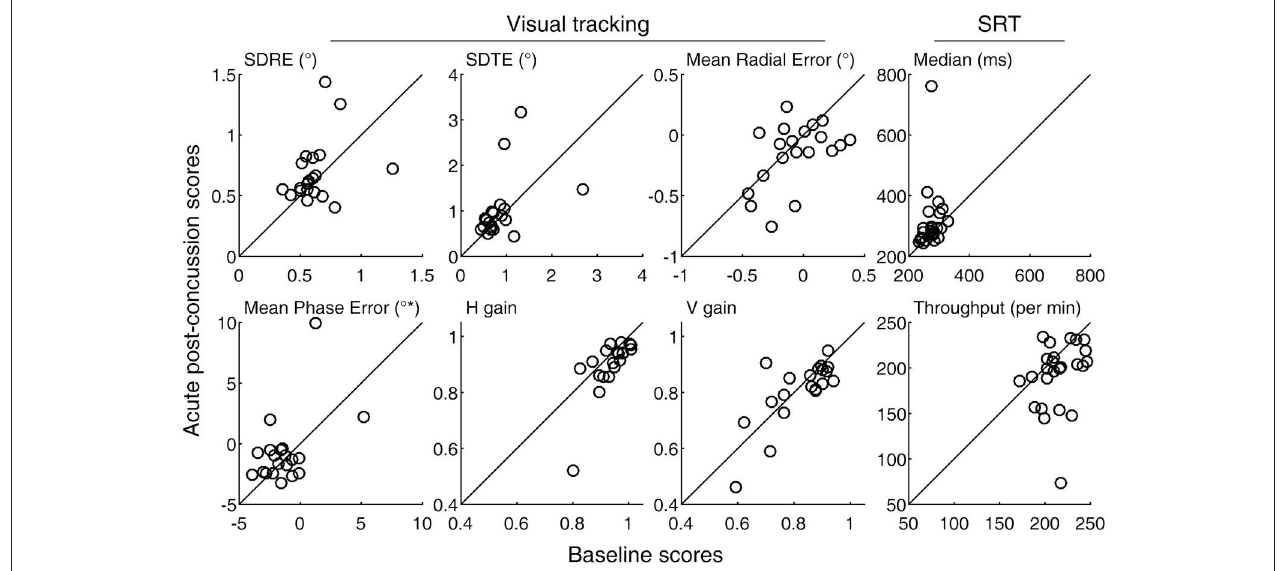
FIGURE 1 | Baseline and acute post-concussion performance scores. Circle markers in each panel indicate individual subjects. The diagonal lines indicate no change from the baseline measurement. Also see Table 1 .